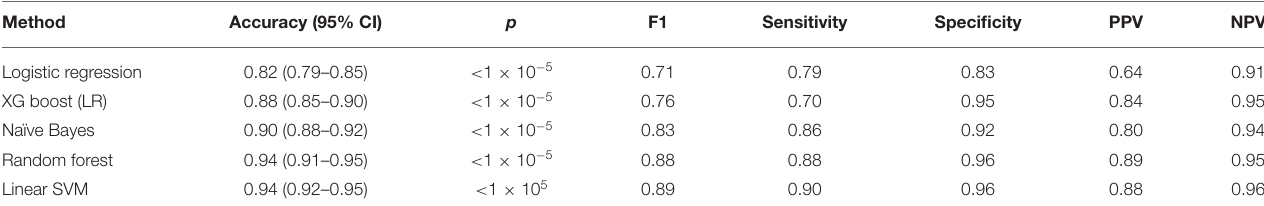
TABLE 4 | Performance of machine-learning classifiers for concerning